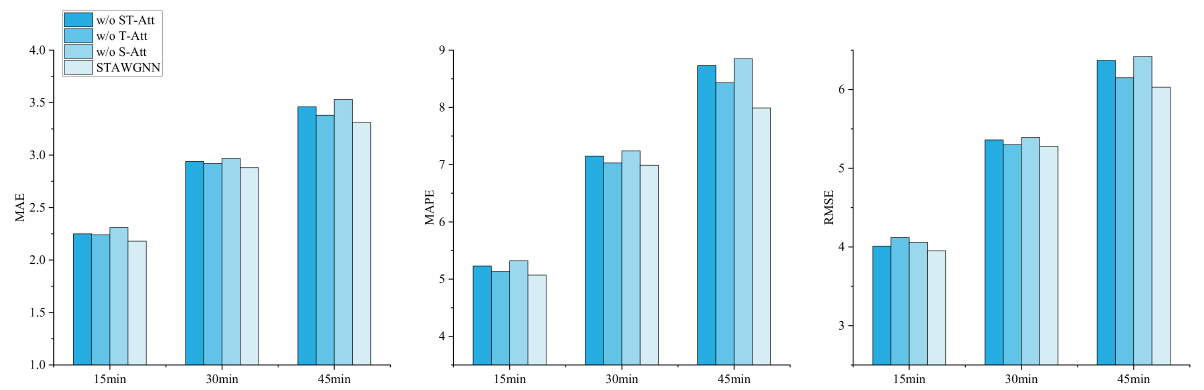
Figure 6. Component analysis of STAWGNN on the PEMSD-BAY dataset.